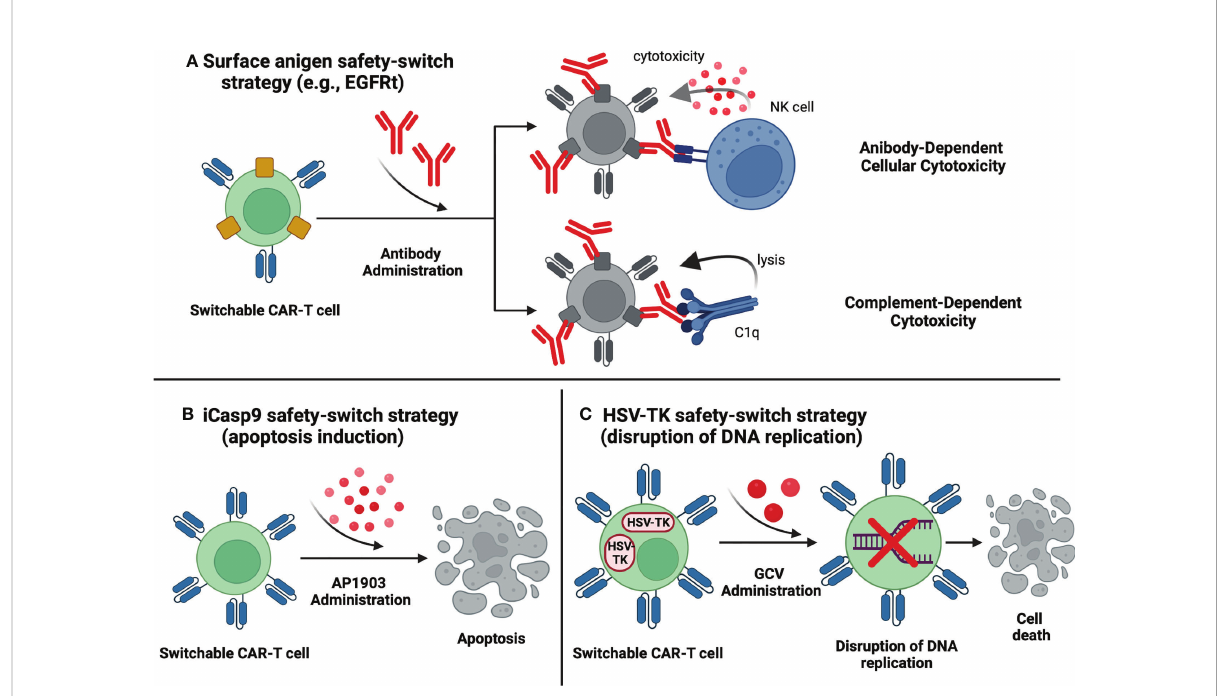
FIGURE 4 Switchable CAR-T cells – safety-switch strategies. (A) Surface antigen safety-switch strategy. The CAR-T cell is programmed to express a surface protein that can be targeted by a speci fi c antibody. The binding of the antibody enables the removal of the CAR-T cells via antibody- dependent cytotoxicity or complement-dependent cytotoxicity. (B) Induction of apoptosis. Administration of AP1903 elicits dimerization of inducible caspase 9 (iCasp9) which in turn leads to activation of proapoptotic molecules and subsequent apoptosis of the iCasp9-transduced CAR-T cell. (C) HSV-TK safety-switch strategy. The HSV-TK gene codes an enzyme that transforms an inactive prodrug (GCV) into a competitive inhibitor of DNA polymerase. As a result, DNA replication is disrupted, and CAR-T cell undergoes apoptosis. Created with